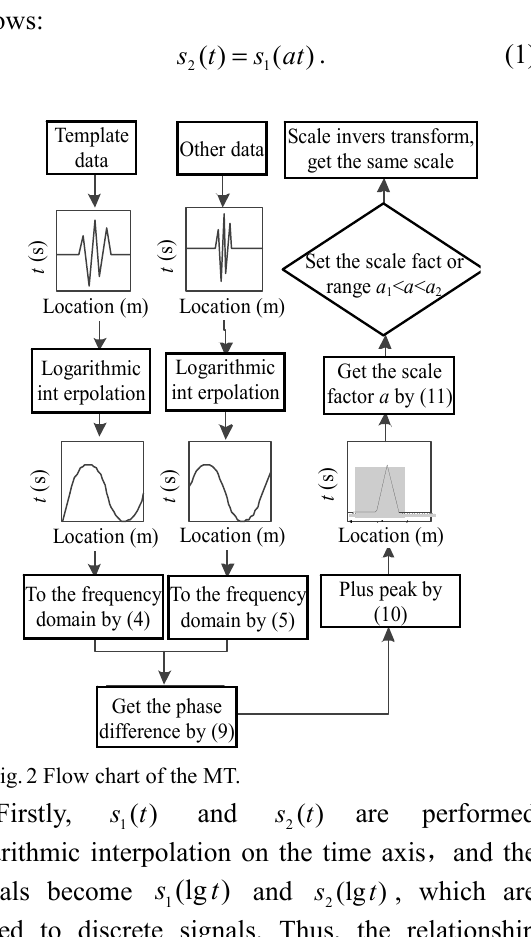
Fig. 2 Flow chart of the